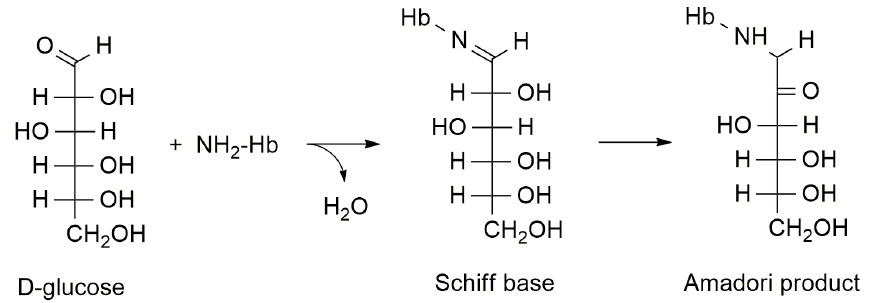
Figure 1. Chemical principles of hemoglobin glycation, Hb = hemoglobin.